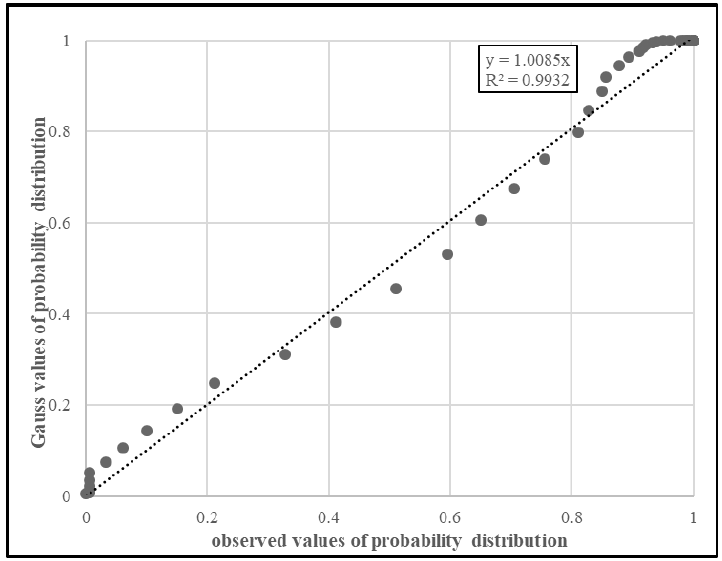
Figure 4. Calibration results of error forecasting distribution.